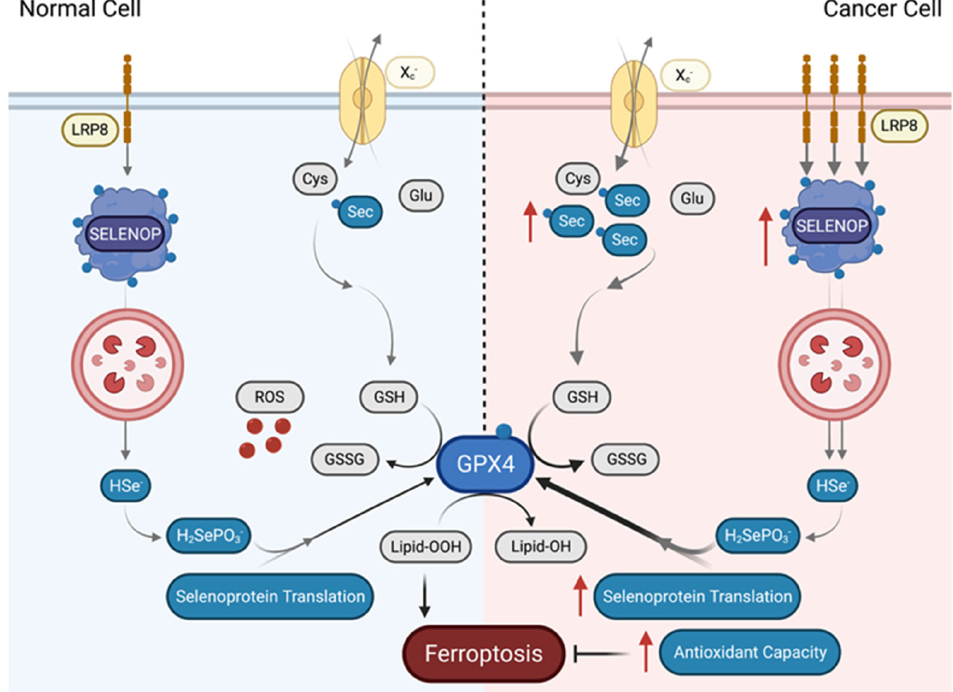
Figure 2 . Cancer cells resist ferroptosis by increasing uptake of Se. In normal cells, ferroptosis is triggered after accumulation of toxic lipid peroxides. Certain cancer cells, however, can render themselves resistant to ferroptosis through increased uptake of Se either through the X c − antiporter in the form of Sec or through increased uptake of SELENOP through LRP8 into lysosomes. In the lysosome, Se is then postulated to be released via SCLY decomposition of SELENOP in order to provide the cancer cell with a pool of Se. This increases GPX4 expression through increased selenoprotein translation, and thereby expands the antioxidant capacity of the cancer cells, rendering them resistant to ferroptosis. Sec, selenocysteine; X c —, cysteine-glutamate antiporter; Glu,